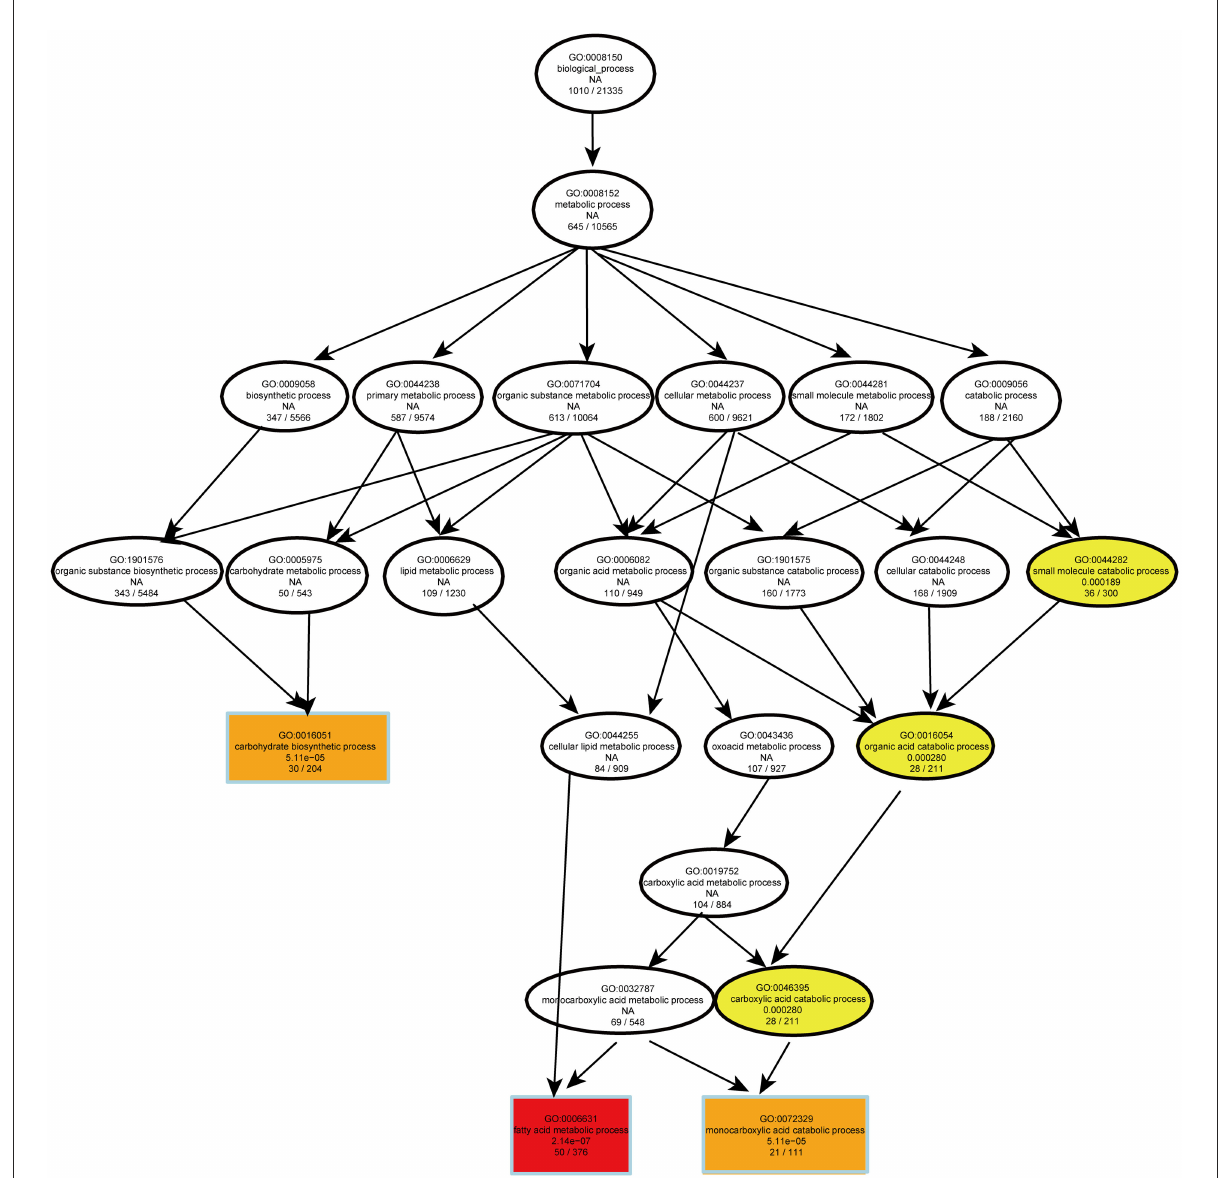
FIGURE7 Directed acyclic graph of GO term enrichment analysis for significantly downregulated DEGs in the lung of 2% phytosterol-feeding